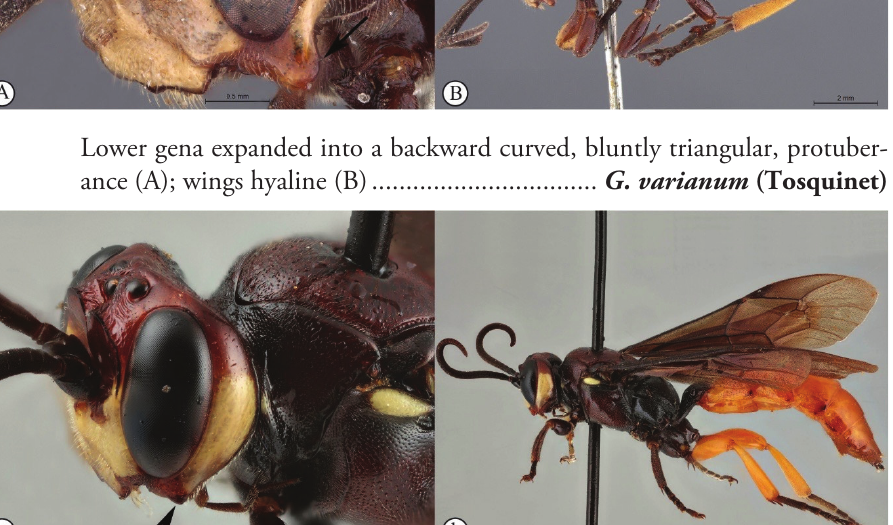
– Lower gena not expanded into a backward curved protuberance (a); wings infuscate (b) ..................... G. fumosum Broad, Rousse & van Noort, sp.